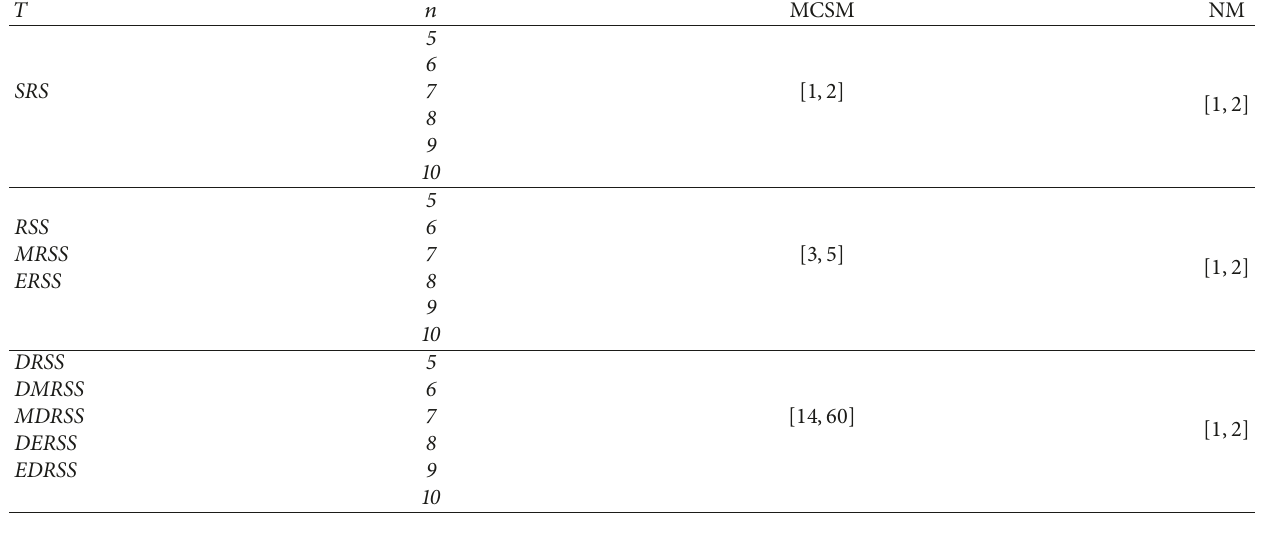
Table 3: Time (expressed in minutes) consumed by the MCSM and NM for computing power 1 − 𝛽 at different choices of 𝑇 and 𝑛 . 𝑇